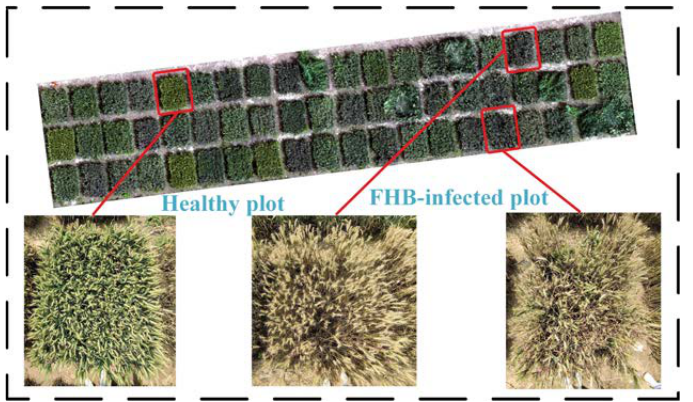
Figure 2. Distribution of images of the canopy experimental plots with the plots corre- sponding to the UAV multispectral imagery. the UAV multispectral